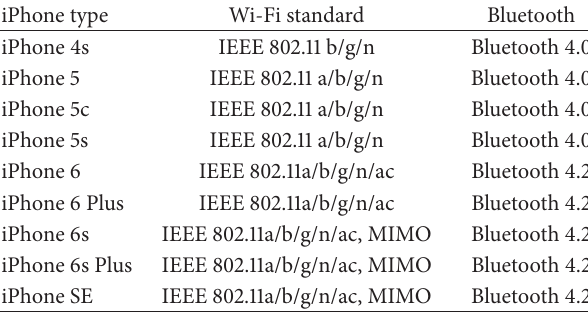
Table 1: Wi-Fi standard and Bluetooth of each